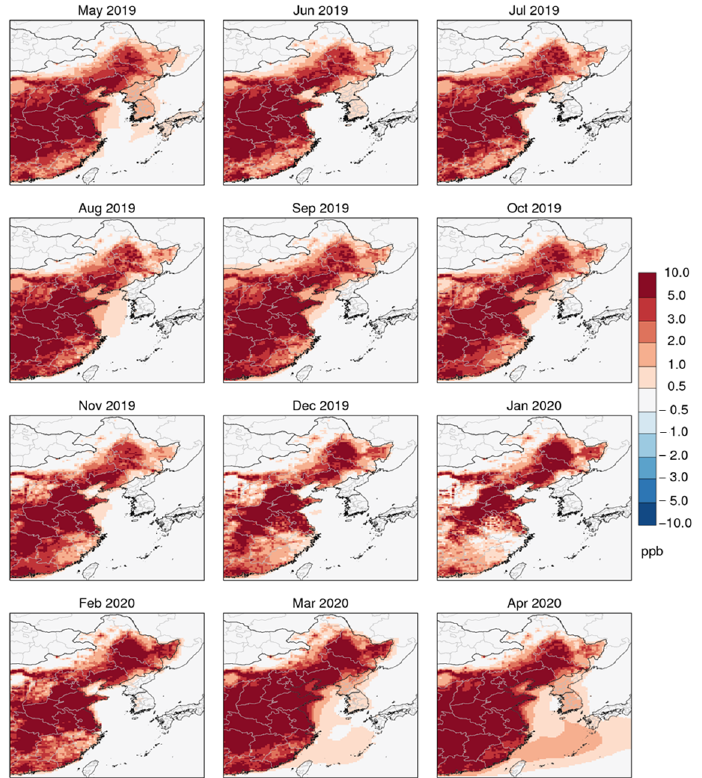
Figure 8. Simulated monthly NH 3 zero-out contributions of Chinese NH 3 emissions in Northeast Asia from May 2019 to April 2020. The darker red color represents the higher Chinese NH 3 emission impacts.